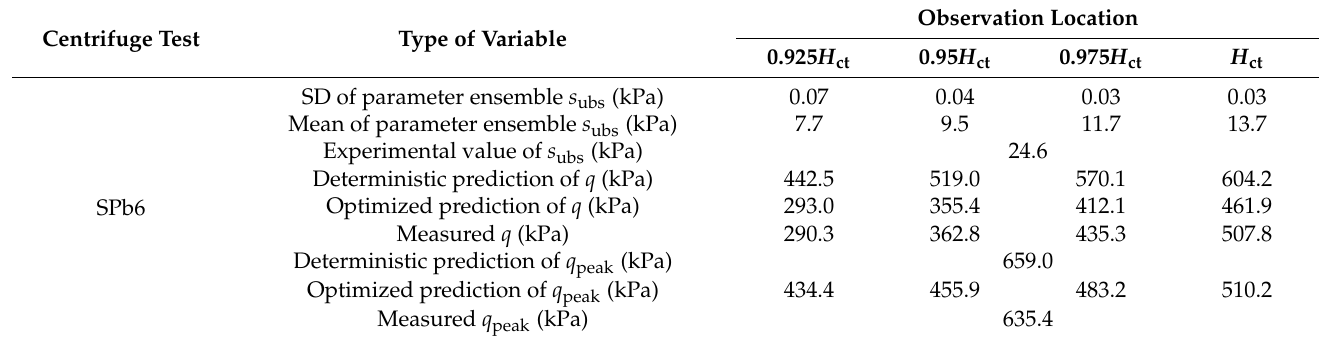
Table 7. Variations of data during the process of parameter optimization for Test